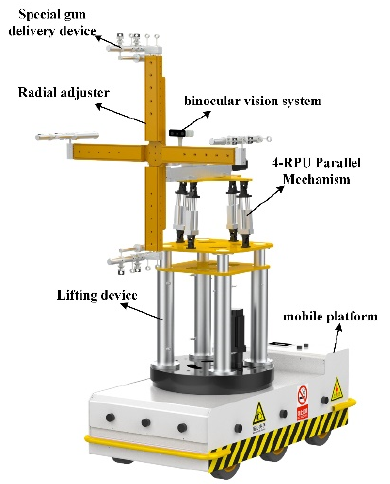
Figure 1. Hybrid condenser cleaning robot.